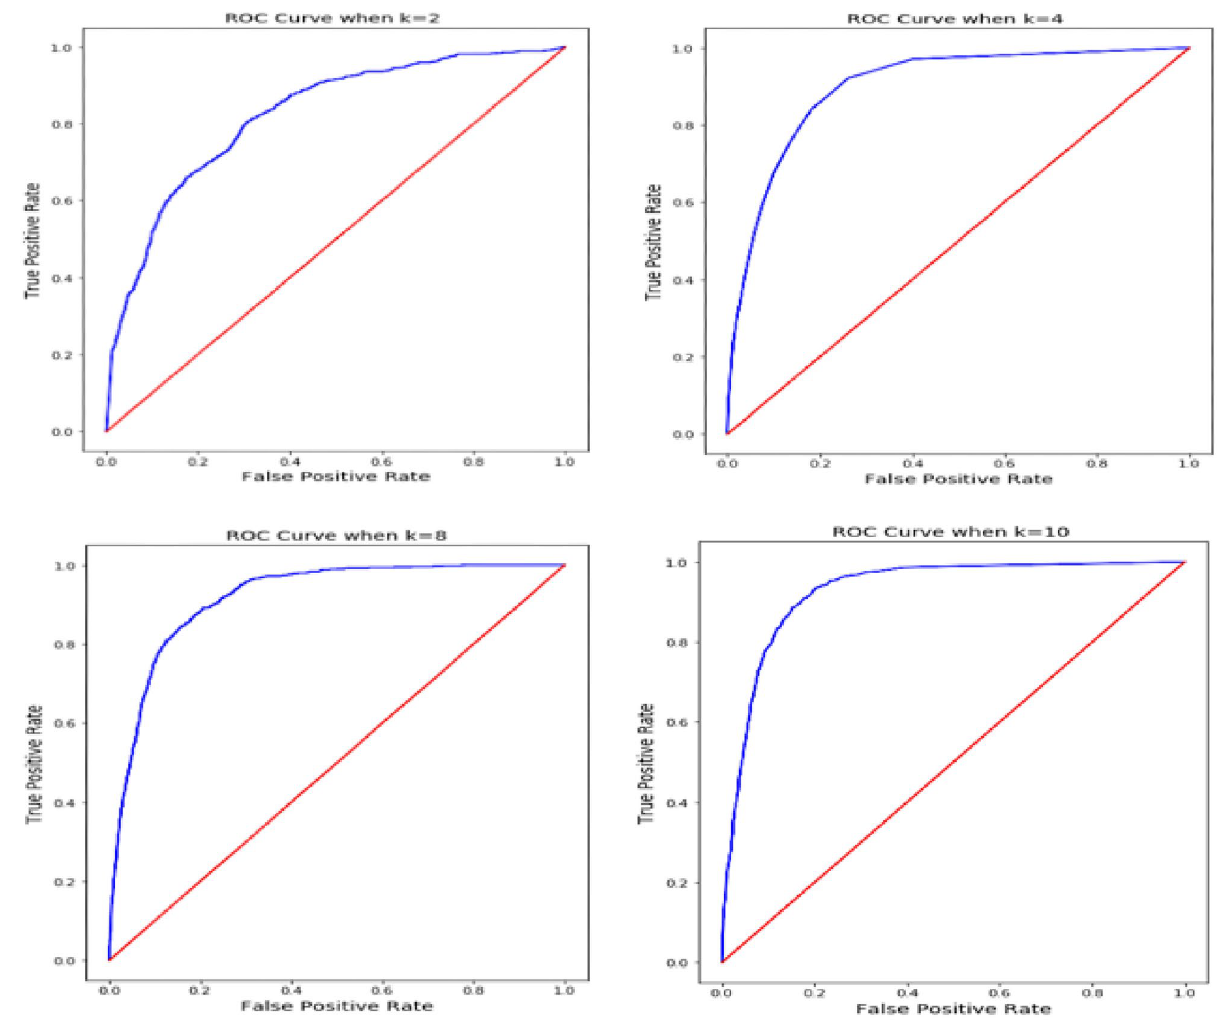
Figure 11. ROC curves associated with k-fold